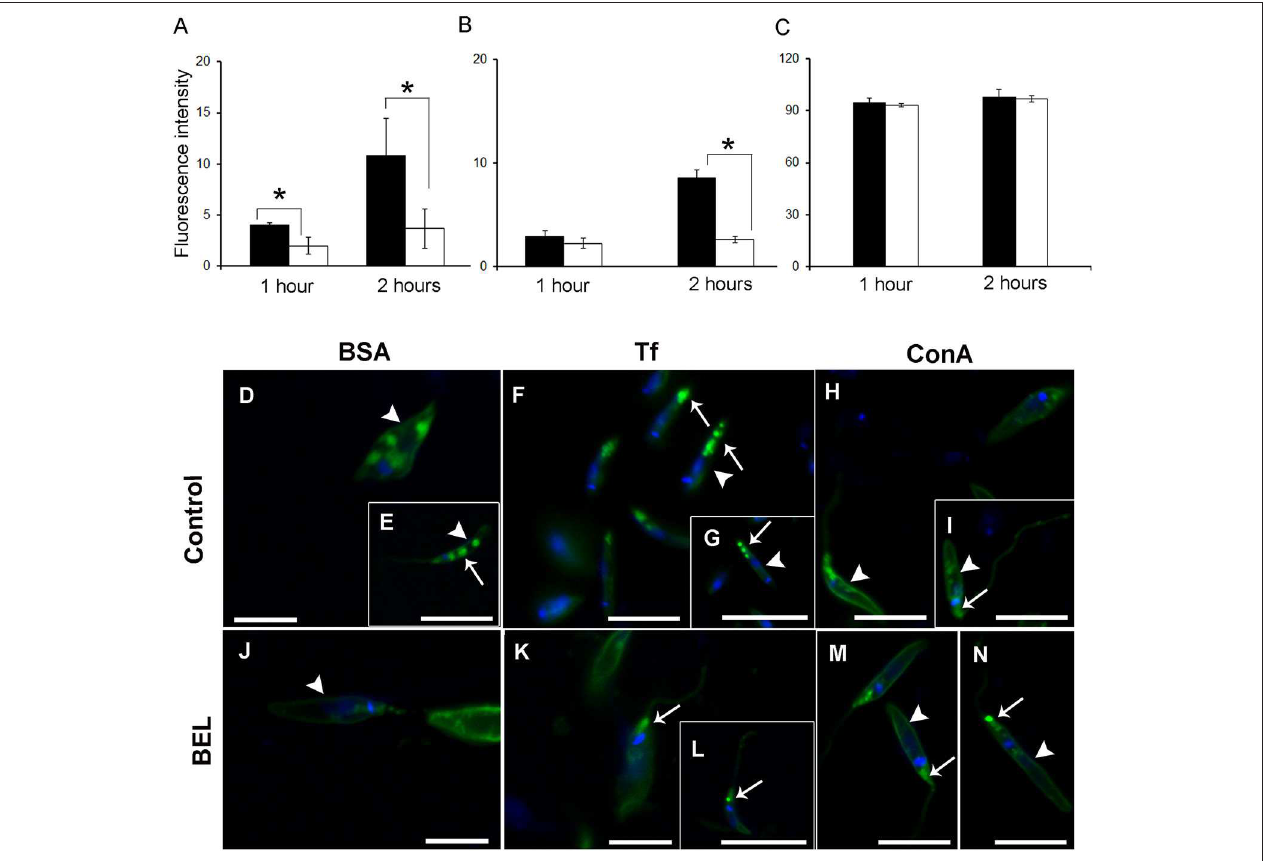
FIGURE 7 | Influence of bromoenol lactone (BEL) on the endocytic activity of Leishmania amazonensis . Promastigotes were incubated with (A) bovine serum albumin (BSA), (B) transferrin (Tf), and (C) Concanavalin A (ConA) tracers and the fluorescence intensity analysis by flow cytometry. Data represent mean ± SEM of three independent experiments, performed in duplicates. * p < 0.05. (D–I) Untreated controls and (J–N) BEL-treated promastigotes were incubated with Alexa Fluor 488-labeled BSA (D,E,J) , Tf (F,G,K,L) , and ConA (H,I,M,N) for 2h. In control cells, labeled BSA and Tf (D–G) were observed on the cell surface (arrowheads) and in cytoplasmic compartments mainly the ones at the posterior end of the cells (arrows in E–G ). In BEL treated cells, BSA (J) and transferrin (K,L) signal occur at the cell surface (arrowhead in J ) and at the flagellar pocket (arrows in K,L ). Control cells incubated with fluorescent ConA had intense signal on the cell surface (arrowheads in H,I ), and in the flagellar pocket (arrow in I ) and this labeling pattern was not altered by treatment with BEL (M,N) . The DNA was stained with DAPI. Bars: 20 µ